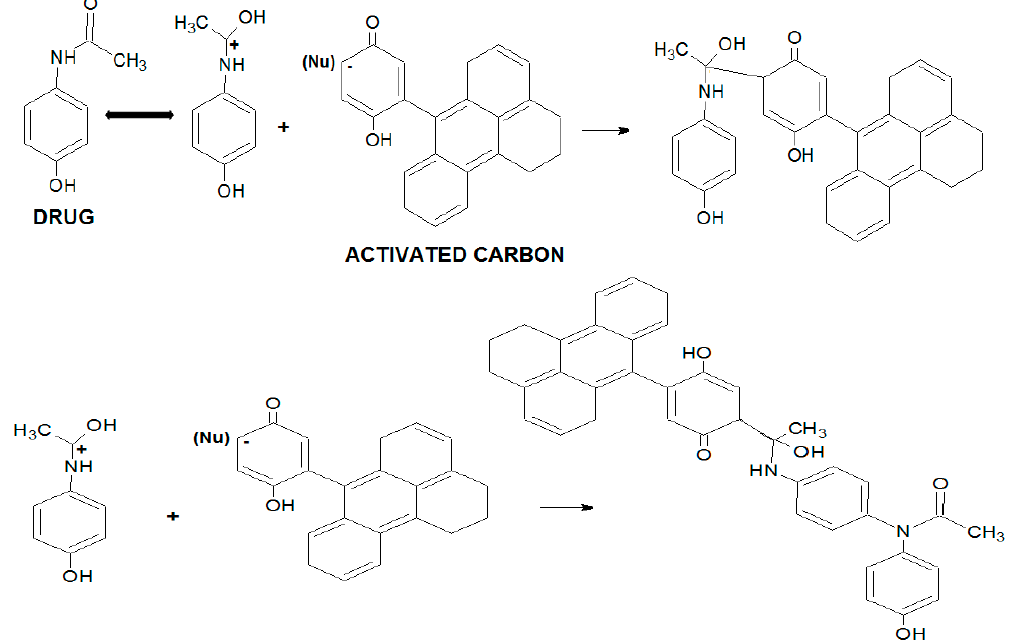
Figure 3. Nucleophilic addition reaction between activated carbon and paracetamol.